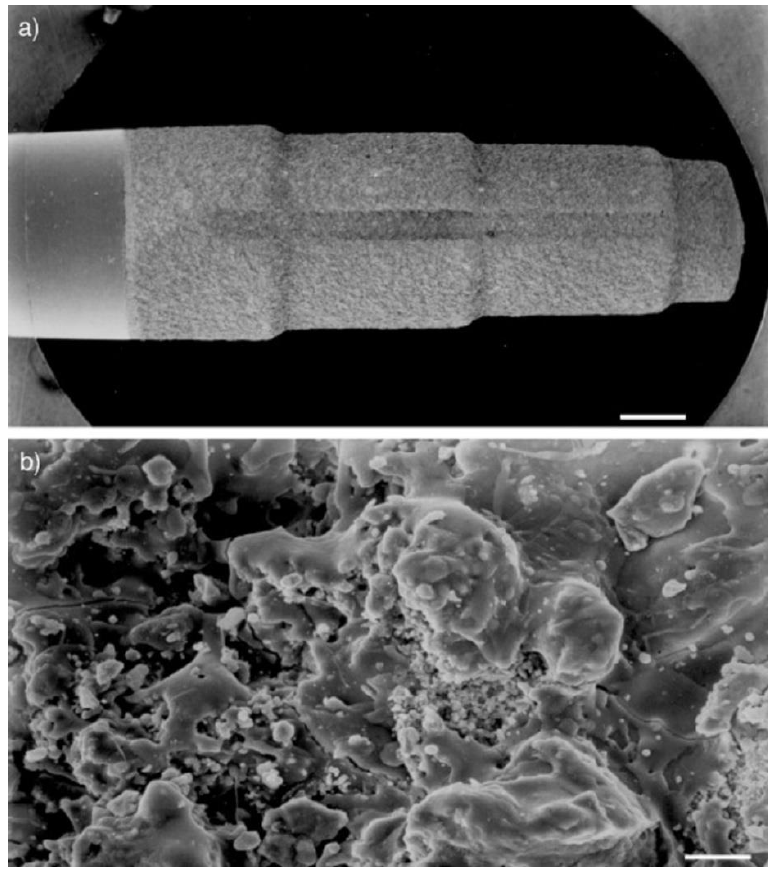
Figure 6. Dental implants (by Friadent) coated with CaP by a plasma-spray process ( a : 10 × , b : 1000 × magnification; a : 1mm, b : 10 µ m scale bars) (reprinted from ref. [69] with